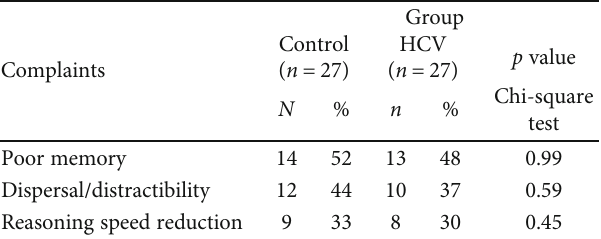
Table 3: Cognitive complaints of patients in the HCV and control